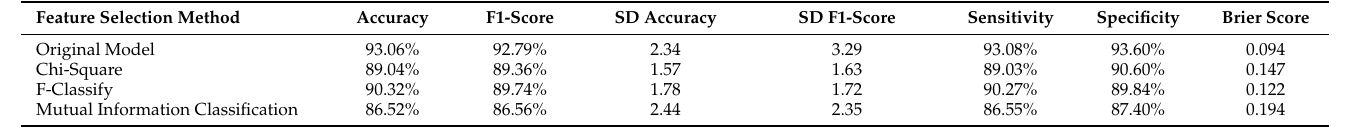
Table 7. Performance evaluation criteria for trained neural network and comparison of different feature selection